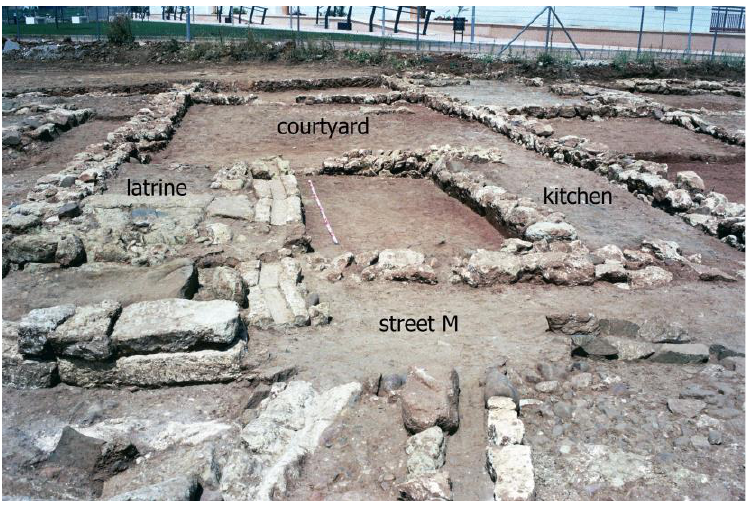
Figure 12. House 124. Kitchen open to the courtyard.